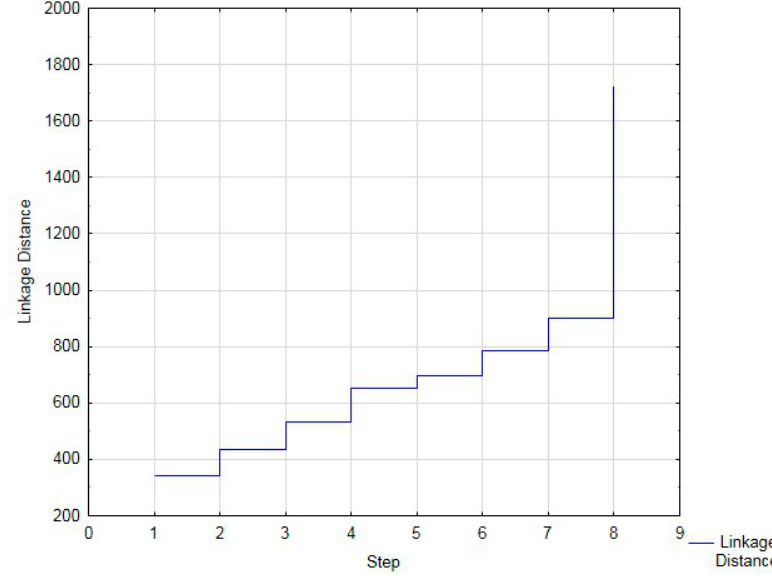
Figure A6. The plot of linkage distances across steps in cluster analysis performed for question referring to sedentary behaviors.